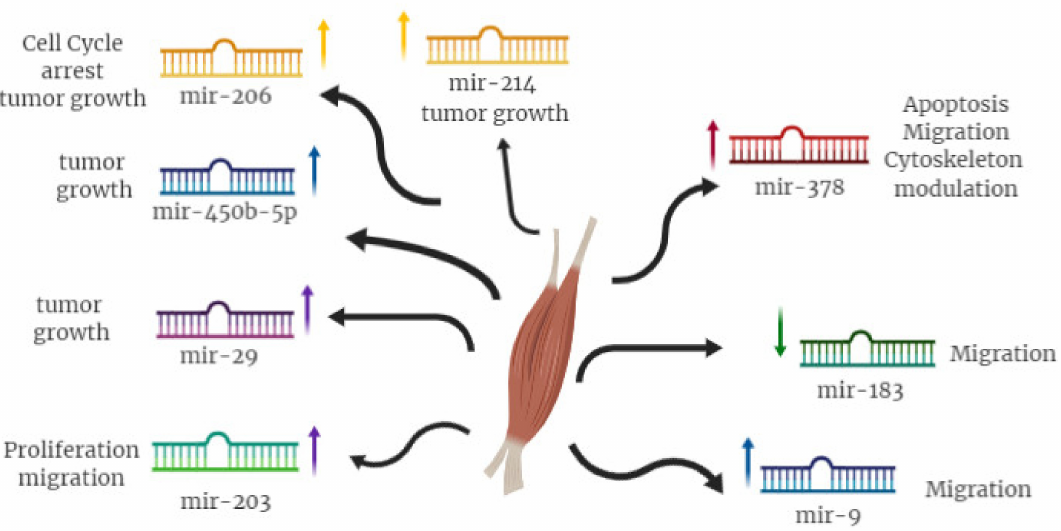
Figure 3. miRNAs modulation in RMS